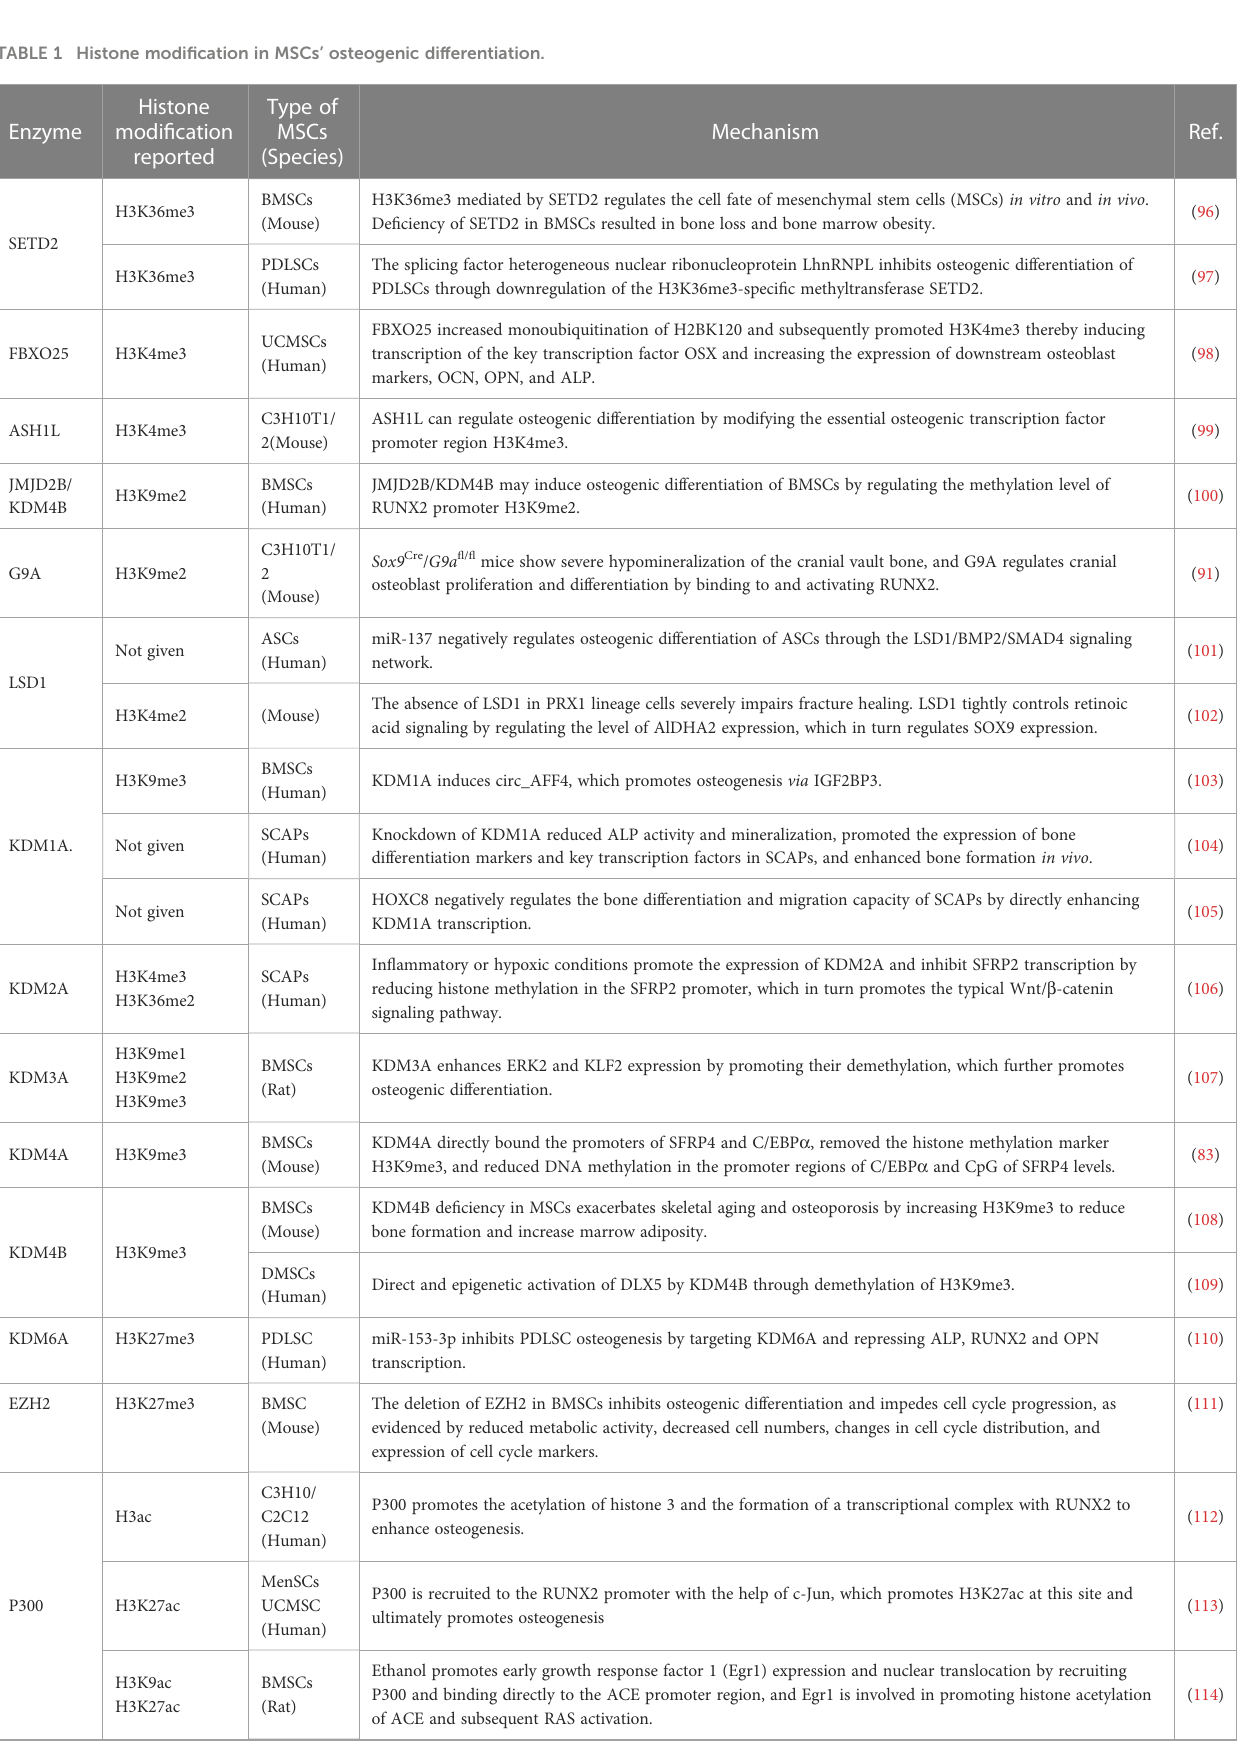
TABLE 1 Histone modi fi cation in MSCs ’ osteogenic